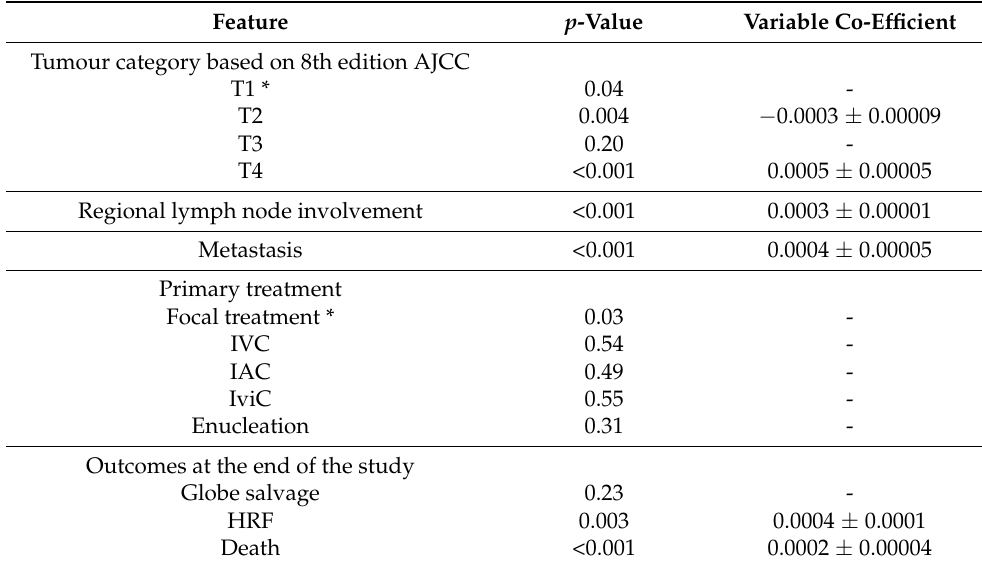
Table 4. Multivariate analysis of marginal linear predictions of factors affected by lag time between first symptom and treatment of retinoblastoma in 692 patients from 10 countries, adjusted for country income level. Feature p -Value Variable Co-Efficient Tumour category based on 8th edition